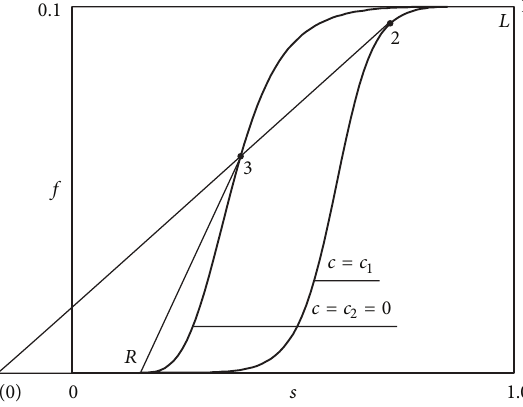
Figure 13: Solution of the lifting system in ( 𝑓 - 𝑠 ) plane when 𝑐 2 = 0